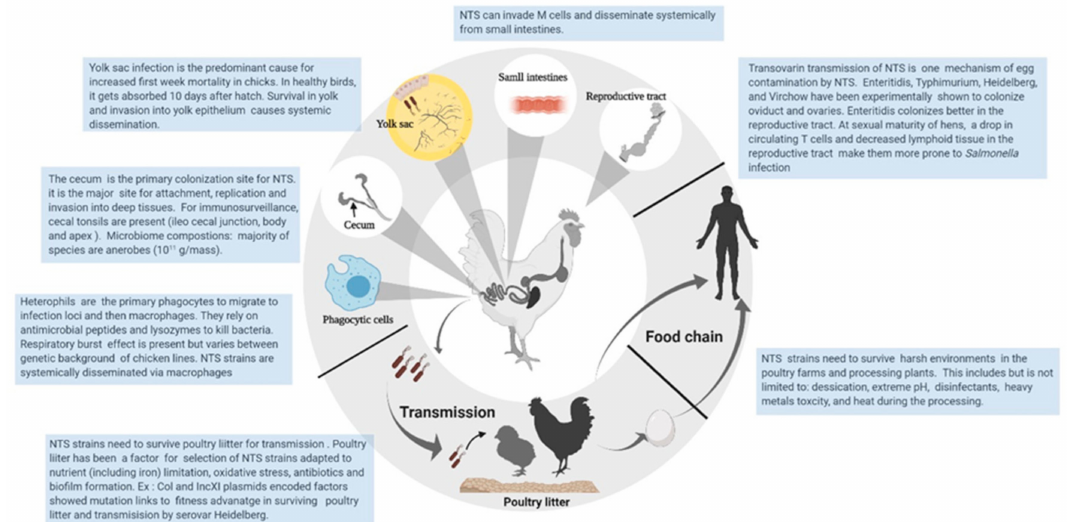
Figure 3. Interaction of non-typhoidal Salmonella strains with chicken and the environment. The role of iron-uptake systems during key steps of Salmonella life cycle illustrated here needs to be investigated in chicken models in future